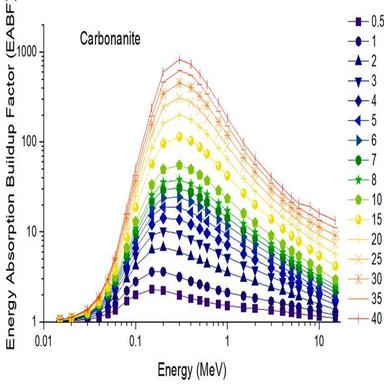
Variation of energy absorption buildup factor (EABF) values of carbonatite as a function of photon energy (MeV).